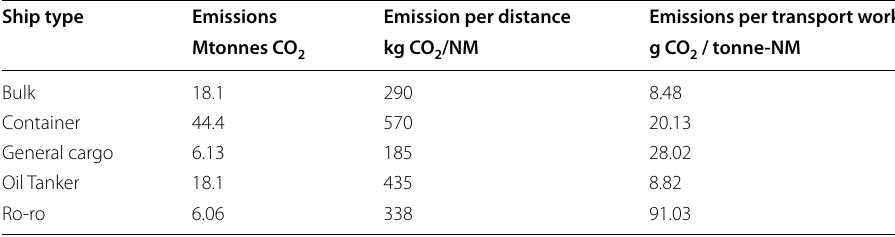
Table 1 Emissions reported in MRV for different shipping